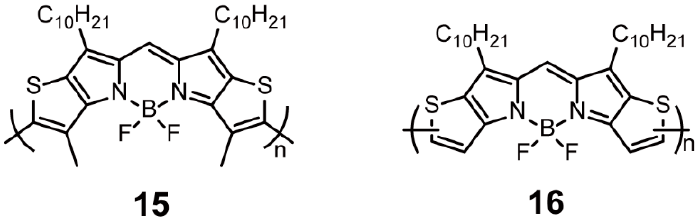
Figure 5. Chemical s tructures of polymers 15 and 16 ( Reproduced with permission from Reference